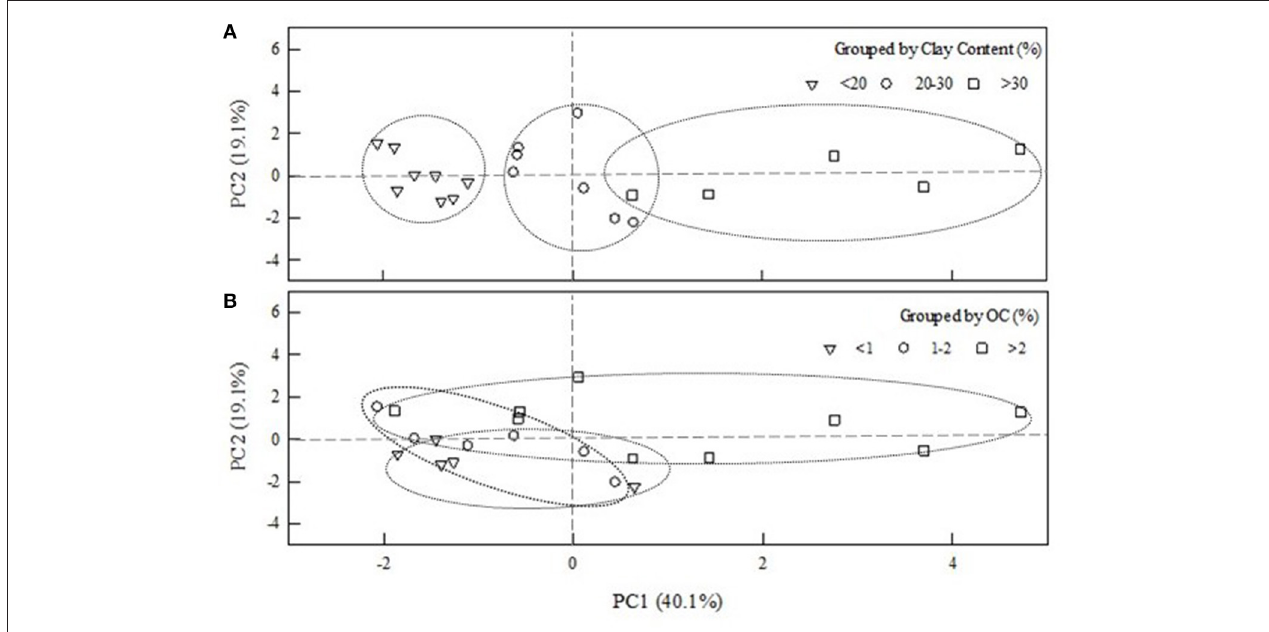
FIGURE 4 | Principal component score plot of selected soil properties and sorption parameters against the first two principle components. (A) clustering of clay content based on low ( < 20%), medium (20–30%), and high > 30%) values plotted against the first two PCs. Similar trends were observed for sorption capacity and distribution coefficient ( K d ) (data not shown). (B) clustering of OC content based on low ( < 1%), medium (1–2%), and high ( > 2%) values plotted against the first two PCs.